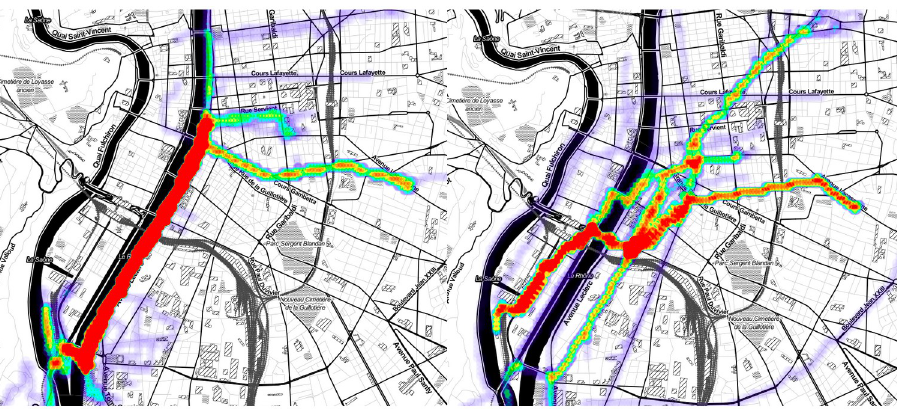
Fig 7. Heat-maps representing the experienced tracks contained in the largest cluster found by DBSCAN in Lyon (left) and their equivalent computed tracks (right).